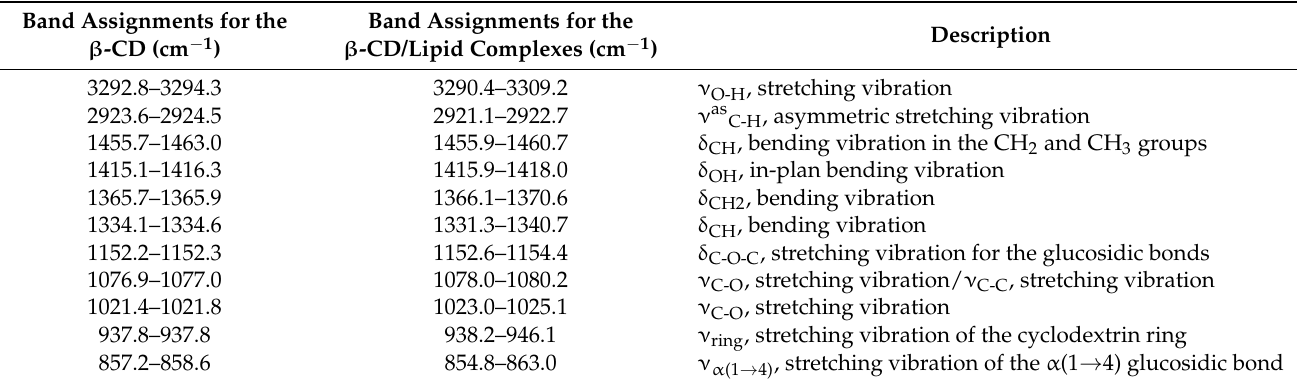
Table 2. Comparisons of the ATR-FTIR band assignments of the β -cyclodextrin hydrate and the corresponding β -cyclodextrin/lipid